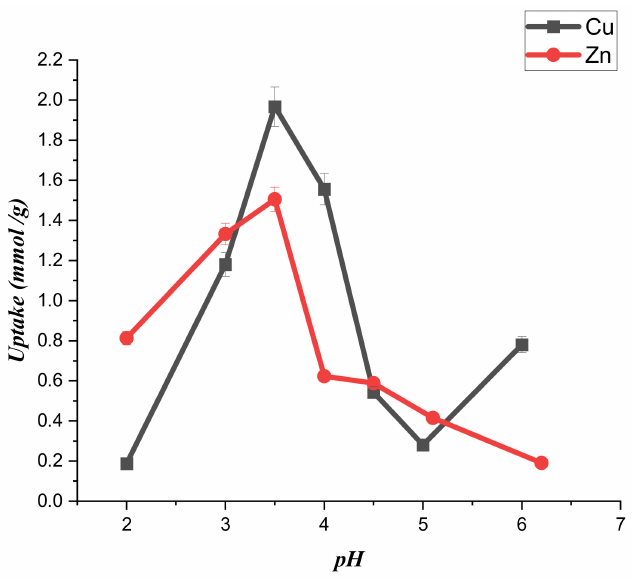
Figure 6. pH effect on the sorption capacity of (CTS-CAA) sorbent towards both copper and zinc ions.